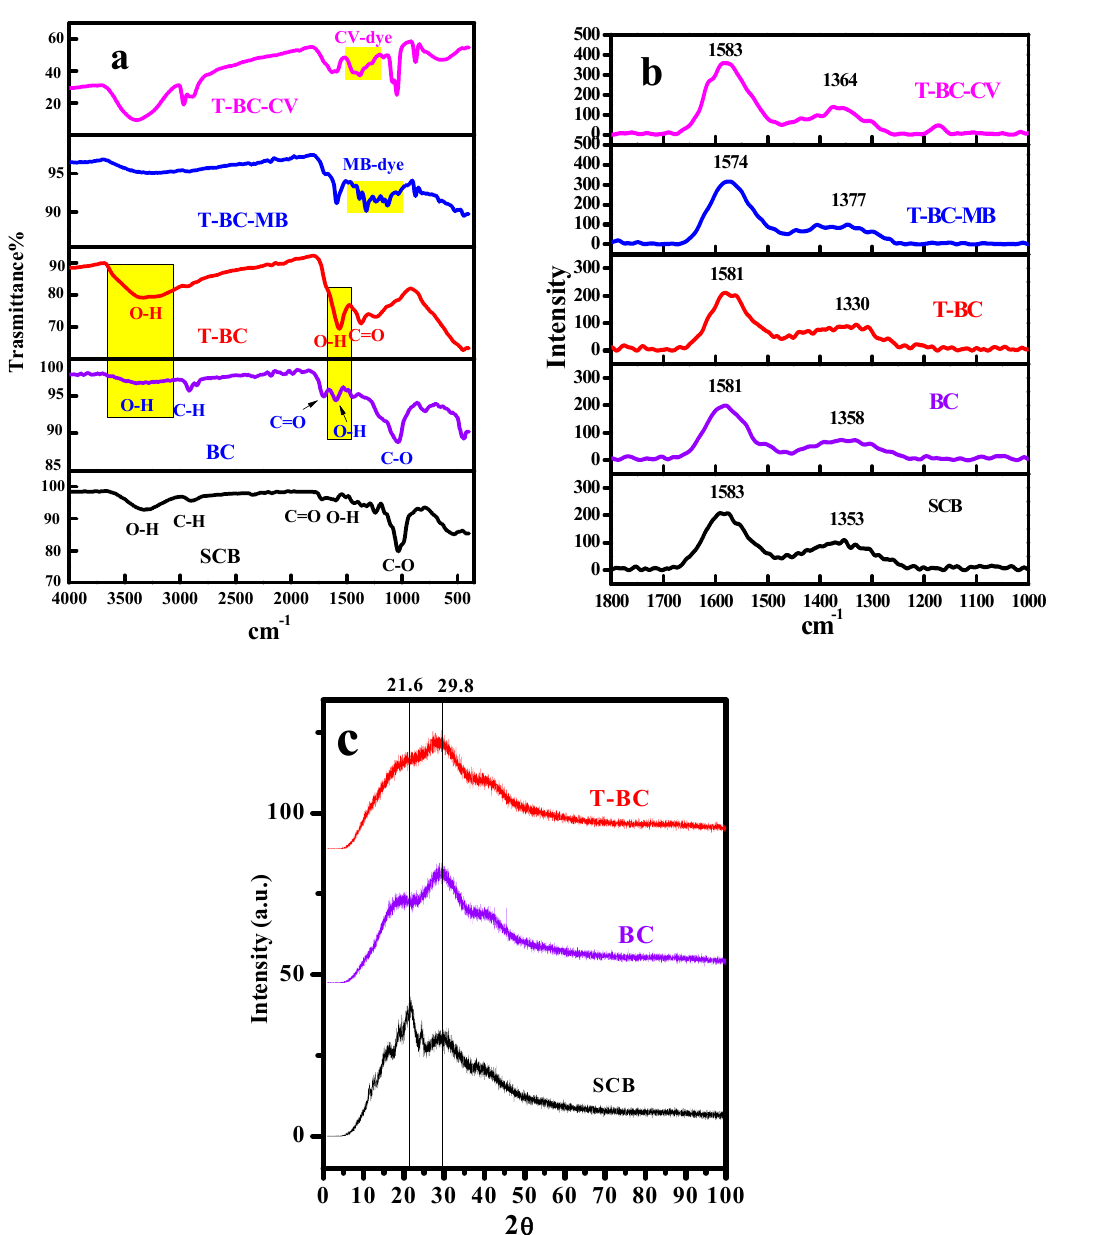
Figure 2. ( a ) FTIR and ( b ) Raman spectra of SCB, BC, T-BC, T-BC-MB, and T-BC-CV, and ( c ) XRD pattern of SCB, BC, and